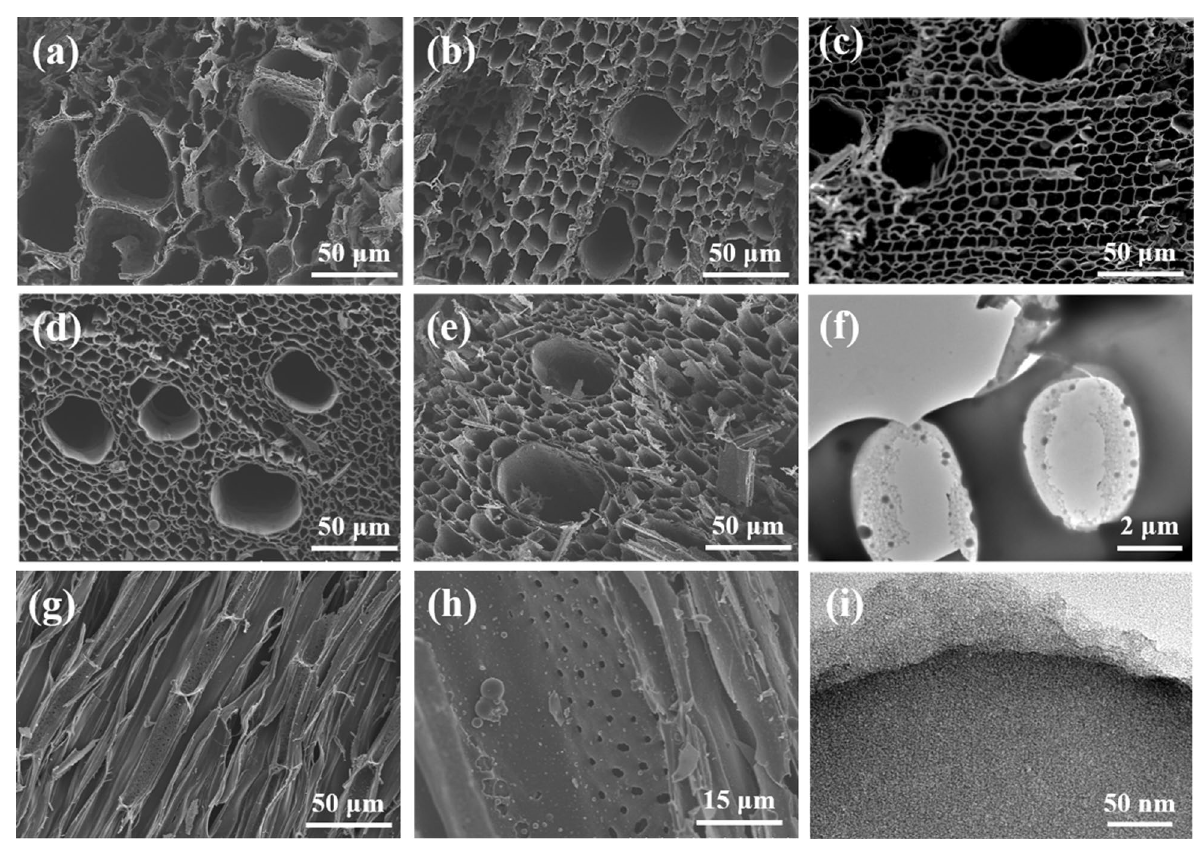
Fig. 2 SEM images of cross sections of a CH-600, b CH-700, c CH-800, d CH-900, e CH-1000 and g , h vertical sections of CH-900; TEM images of f , i CH-900